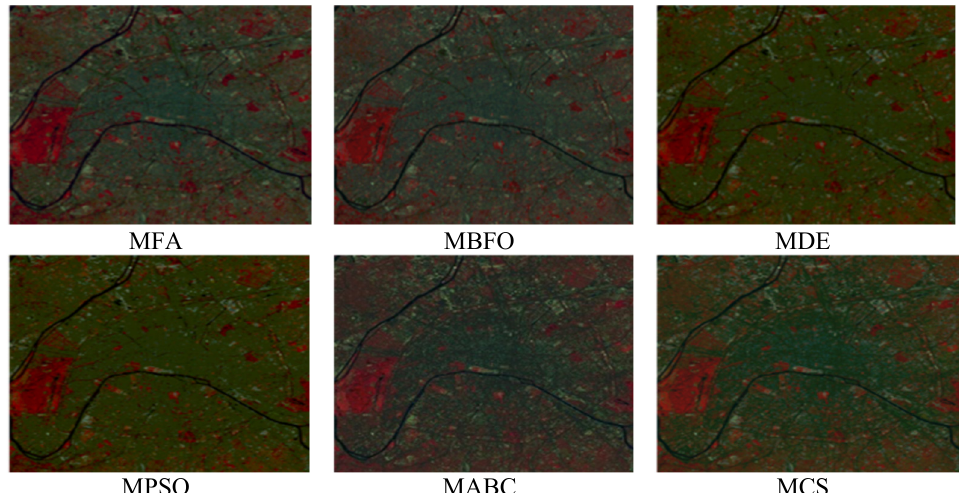
Figure 9. MCS function-based segmented images using MFA, MBFO, MDE, MPSO, MABC, and MCS for thresholding level 2.